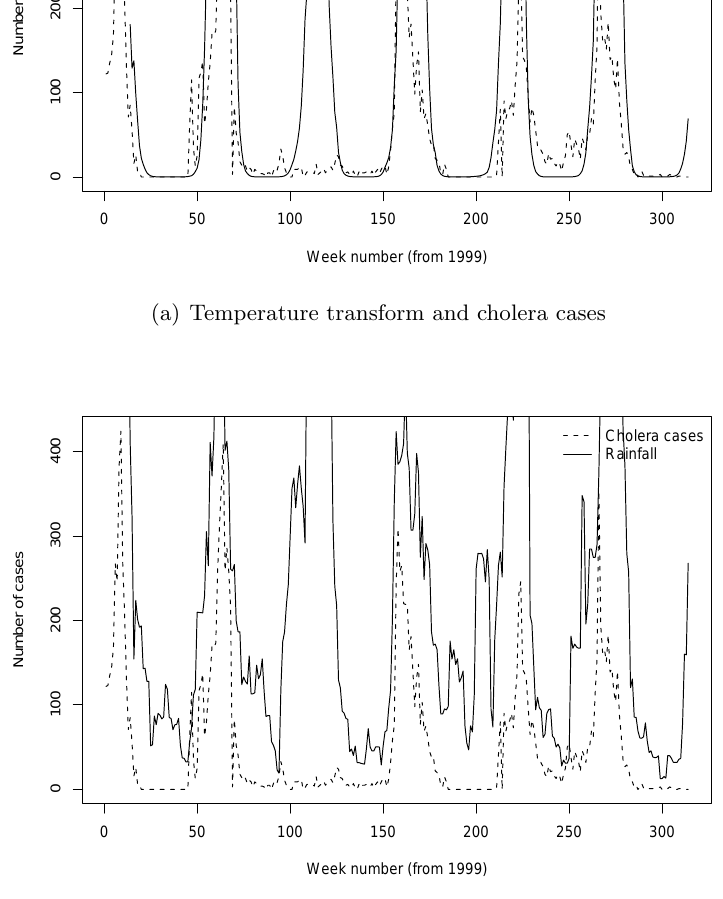
Figure 8: Exponentially transformed cumulative temperature values, and cumulative rainfall plotted against cholera cases. Note how the sudden increases in exponential temperature values closely match the start of cholera outbreaks, and how cumulative rainfall has a similar (but less pronounced) relationship to cholera